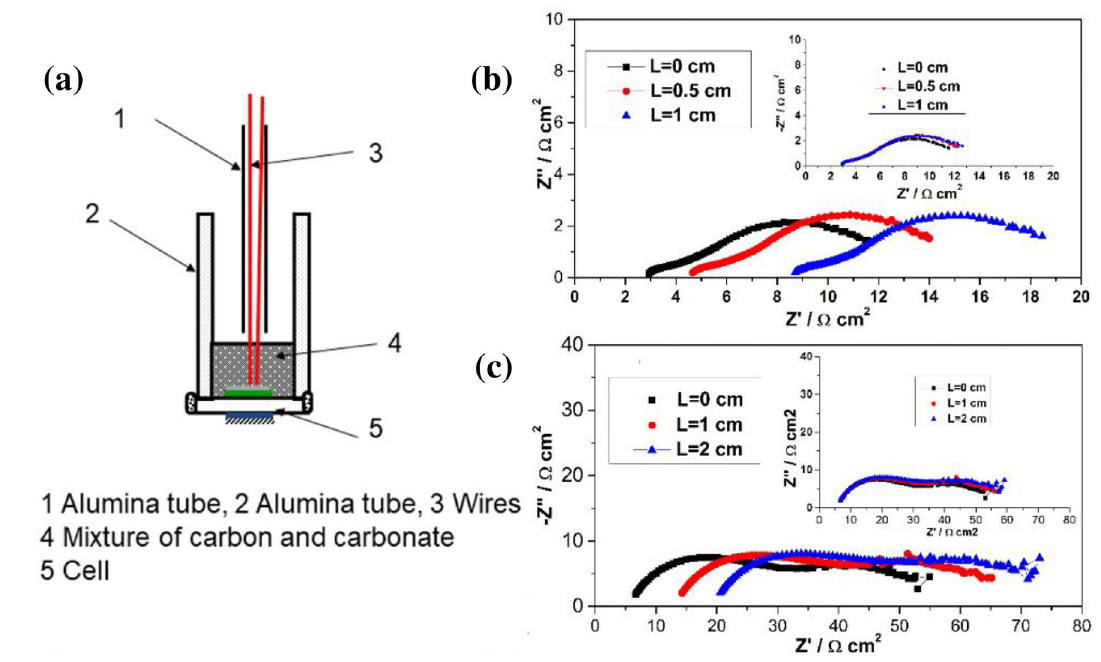
Fig. 7 The electrochemical reaction zone in HDCFC with a NiO- YSZ anode, YSZ electrolyte, LSM-YSZ cathode and 62 mol% Li 2 CO 3 -38 mol%K 2 CO 3 : a configuration of the HDCFC design with